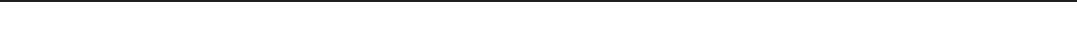
Figure 5. The impact of environmental stressors on reduction of germinated Clostridium difficile spores. Eight log colony forming units (CFU) of C. difficile VA17 spores were exposed to 1 mL of ger- 10 minants in a test tube for 30 minutes under ambient conditions (22˚C, aerobic). Germinated spores were washed 3 times and then 10 µ L (6 log CFU) of the spore suspension was inoculated into the empty well 10 of a glass slide (dry conditions) or a well containing nutrient free agar (moist conditions). The glass slides were placed on the bench top (aerobic conditions) or in an anaerobe containment system (anaerobic con- ditions) for 24 hours. The temperature was maintained at 22˚C for the duration of the experiment. After incubation, the spores were recovered from the slides and the log CFU reduction of spores was deter- 10 mined. The means of data from triplicate experiments are presented. Error bars indicate standard